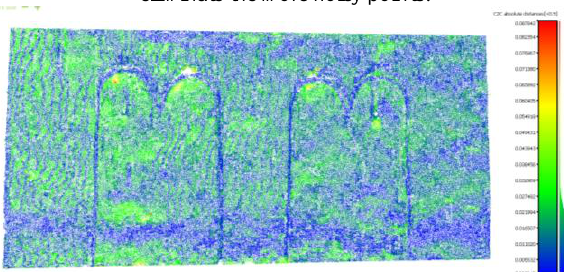
Figure 12. Discrepancies map between the TLS cloud and SURE results(a); in (b) it is possible to notice how the obtained cloud is noisy, although it was already filtered in order to eliminate the more noisy points.